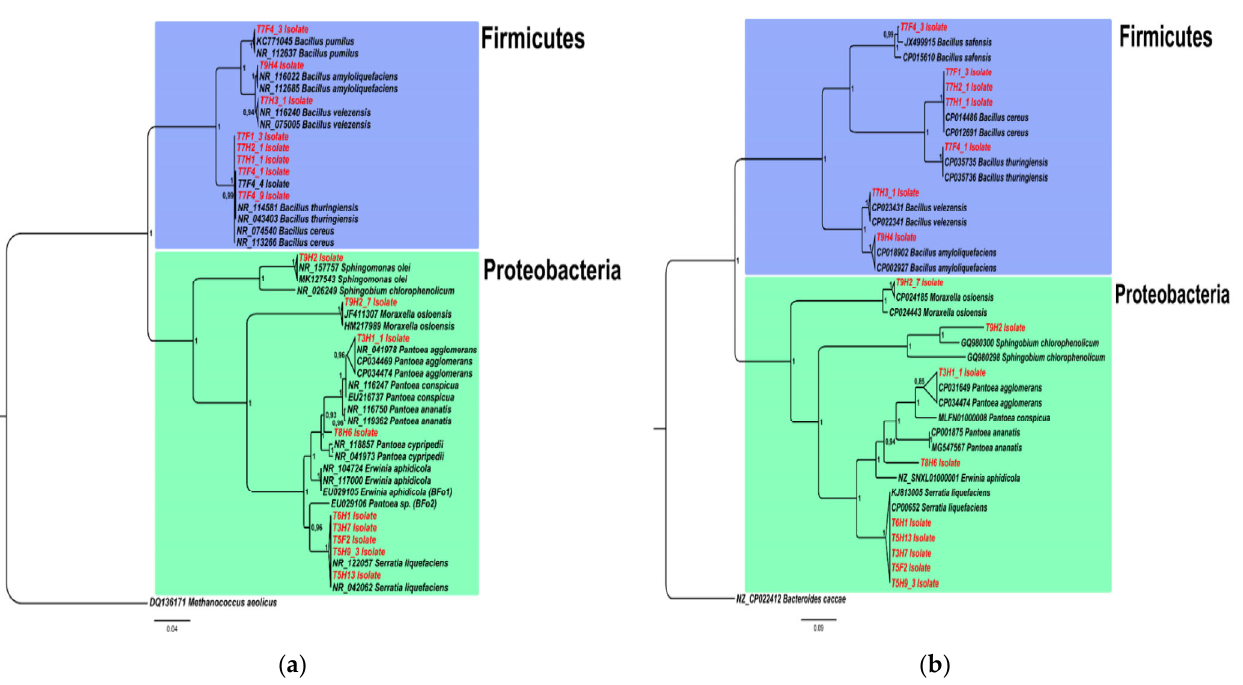
Figure 2. Bayesian dendrograms of bacterial isolates from thrips: ( a ) dendrogram with the 16S rRNA gene, ( b ) dendrogram with the gyrB gene. The dendrograms were generated using the MrBayes program. The bacterial isolates are represented with codes, while the sequences obtained from GenBank have accessions with their respective identifications. The numbers in the nodes correspond to the posterior probability.